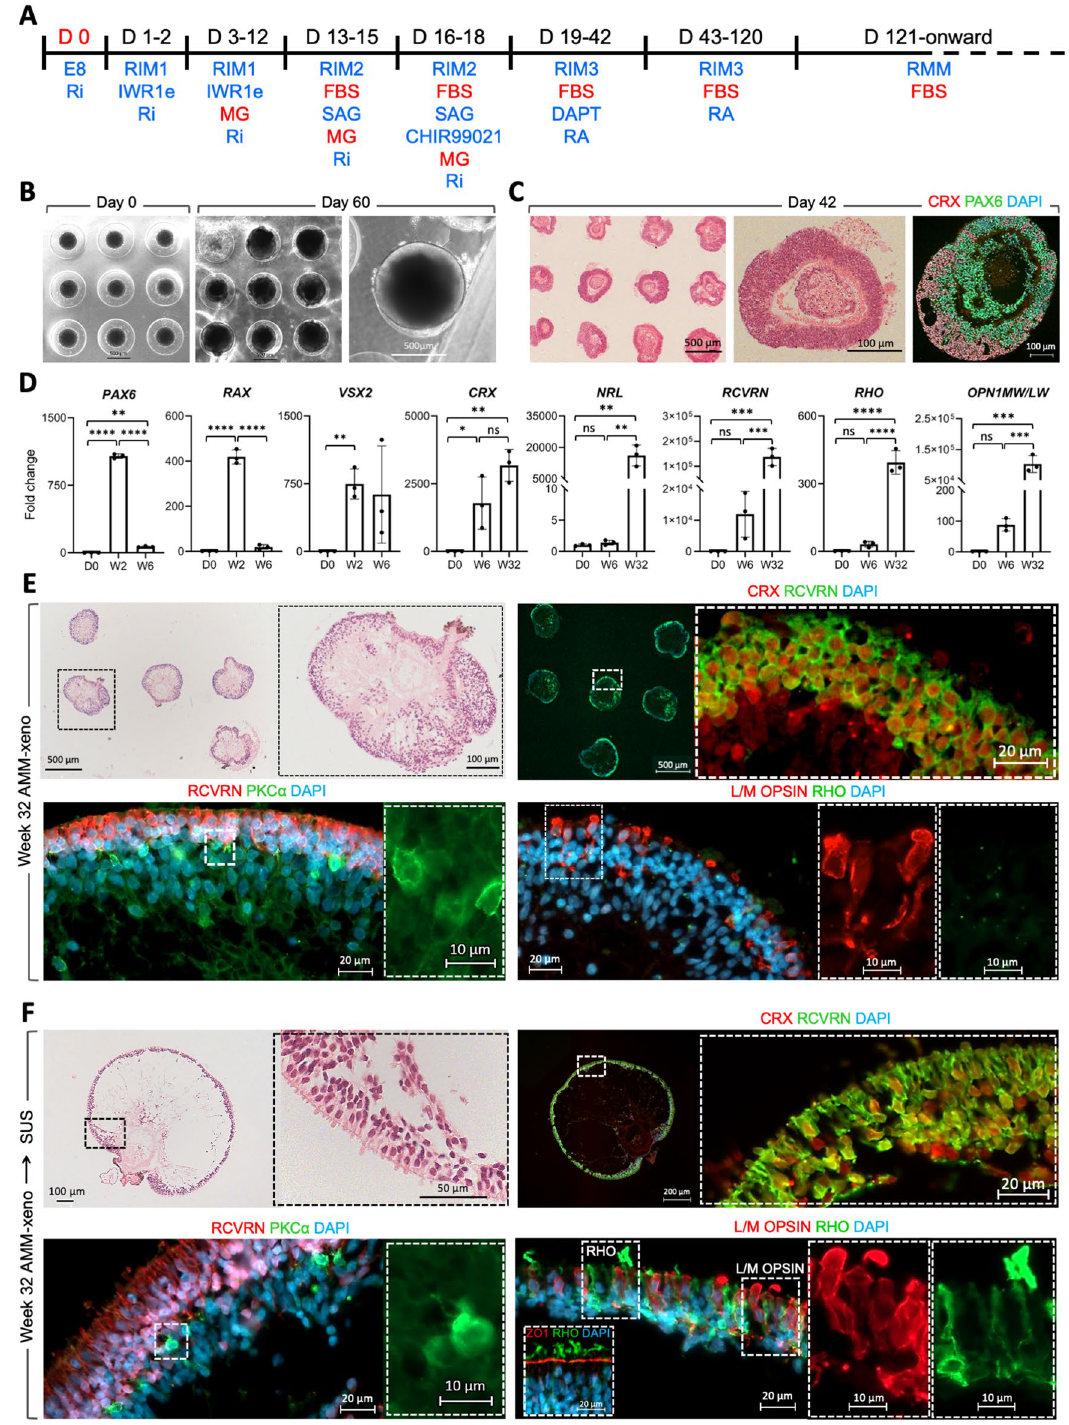
Figure 3. Retinal differentiation in 3D AMM using animal-derived supplements (xeno). ( A ) Schematic of the 3D AMM xeno small molecule protocol ( B ) Bright-field microscopy of aggregates generated from MShef10 ESC line in AMM at day 0 (first image from left) and differentiated 3D optic vesicle-like structures at day 60 of differentiation (scale bars 500 µm) ( C ) Histological and immunohistological analysis of CRX and PAX6 in retinal organoids generated from MShef10 ESC line at day 42 of differentiation. ( D ) RT PCR analysis of relative expression of retinal-specific markers (mean ± SD; n = 3 independently cultured AMMs each containing over 50 OVs from N = 1 ESC line, MShef10. ( E , F ) Histological and immunohistological analysis of CRX, RCVRN, L/M OPSIN, RHO and PKCa at week 32 of differentiation in retinal organoids generated from MShef10 ESC line. 3D retinal organoids which were transferred from AMM into suspension culture from week 6 of differentiation grew larger and maintained laminated organisation and exhibited longer outer segment-like protrusion beyond outer limiting membrane ( F ) compared to organoids which were maintained in AMM throughout the study ( E